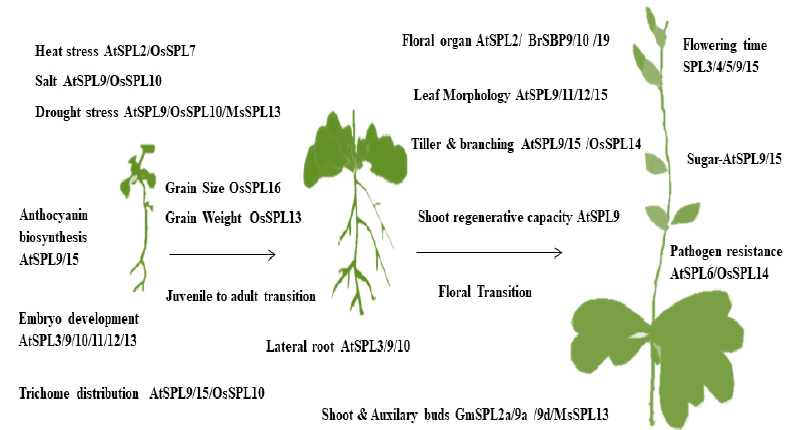
Figure 2. Summary of miR156 / SPL-mediated plant development, including both vegetative and reproductive stages. The miR156 / SPL module serves as a multifunctional gear for plant growth and development, which controls a large number of important agronomic traits.